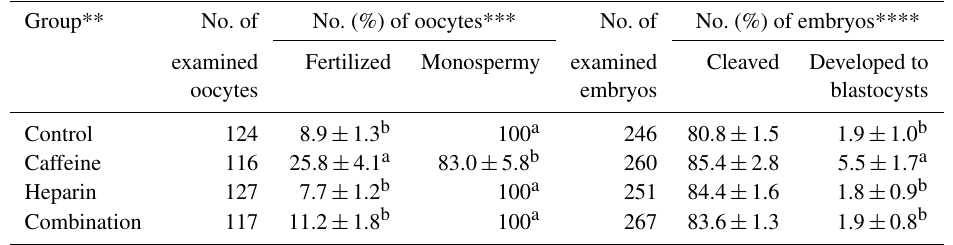
Table 2. Effects of caffeine and heparin supplementation, either alone or in combination, on the fertilization and development of porcine oocytes fertilized with frozen–thawed spermatozoa from microminipig C*.